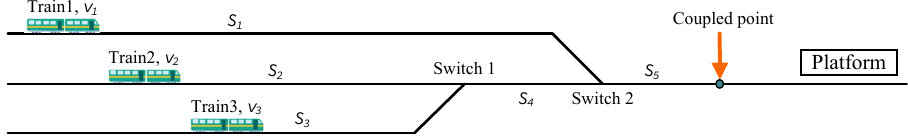
Figure 2. “Coupled point” to “Coupling point” Simulink scenario.